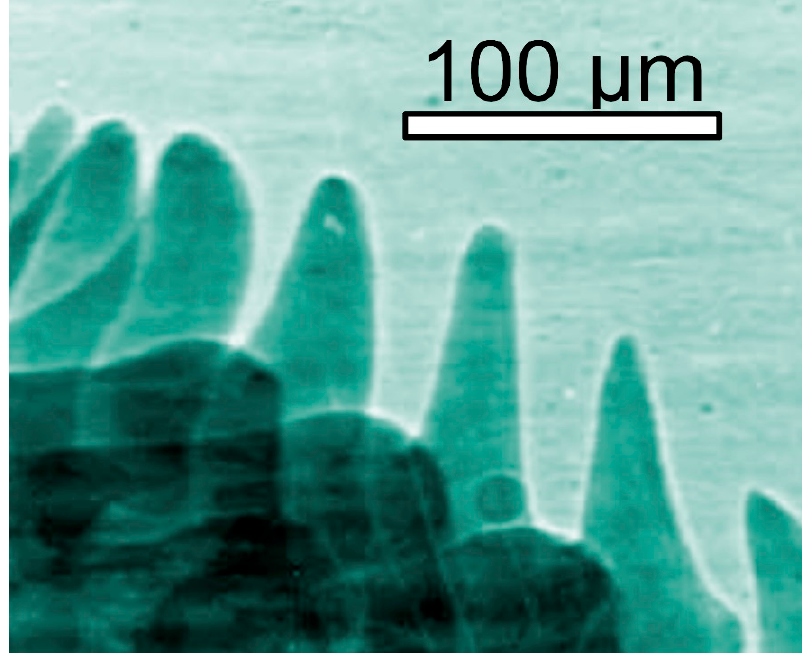
Figure 2. Coherence-based radiograph of part of an insect [12].